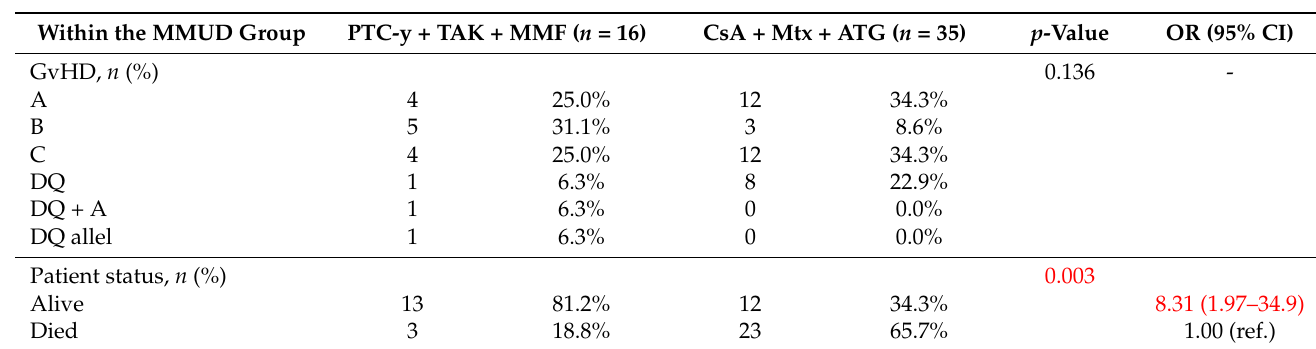
Table 2. GvHD incidence and survival rate in MMUD patients receiving PTCy + TAK + MMF and CsA + Mtx + ATG (in red: p <